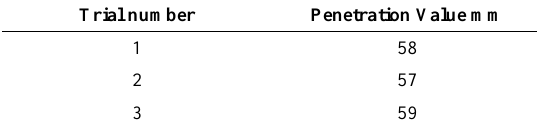
Table 6. Penetration test with adding 15% polymer